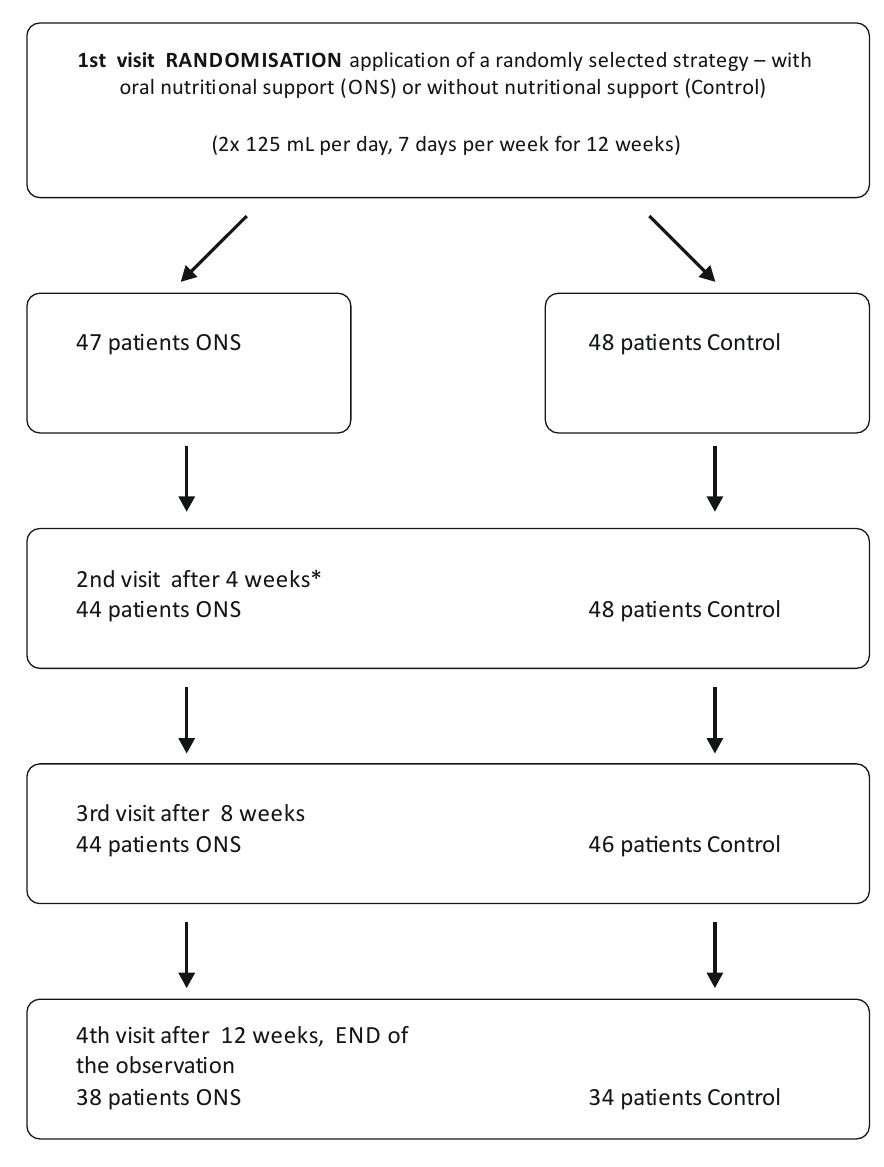
Figure 1. The scheme of the study.